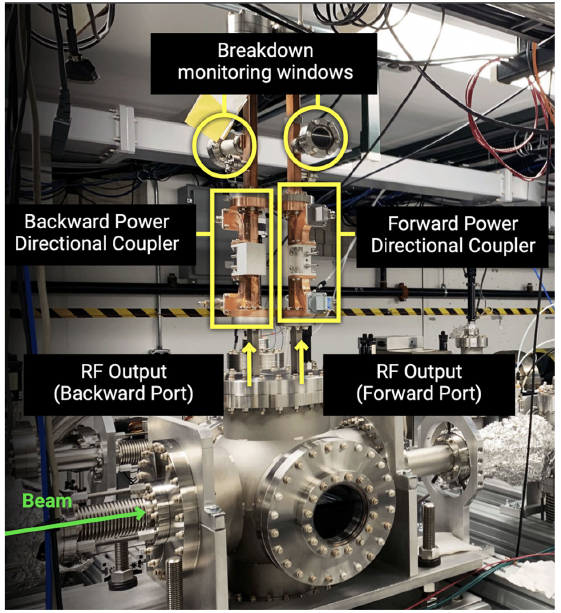
FIG. 15. Vacuum chamber in which the power extractor was installed on the AWA beamline. Both the high power and low power rf output waveguides were sampled with a directional coupler and breakdown-detection diodes (not shown), with the power absorbed by rf loads at the end of the